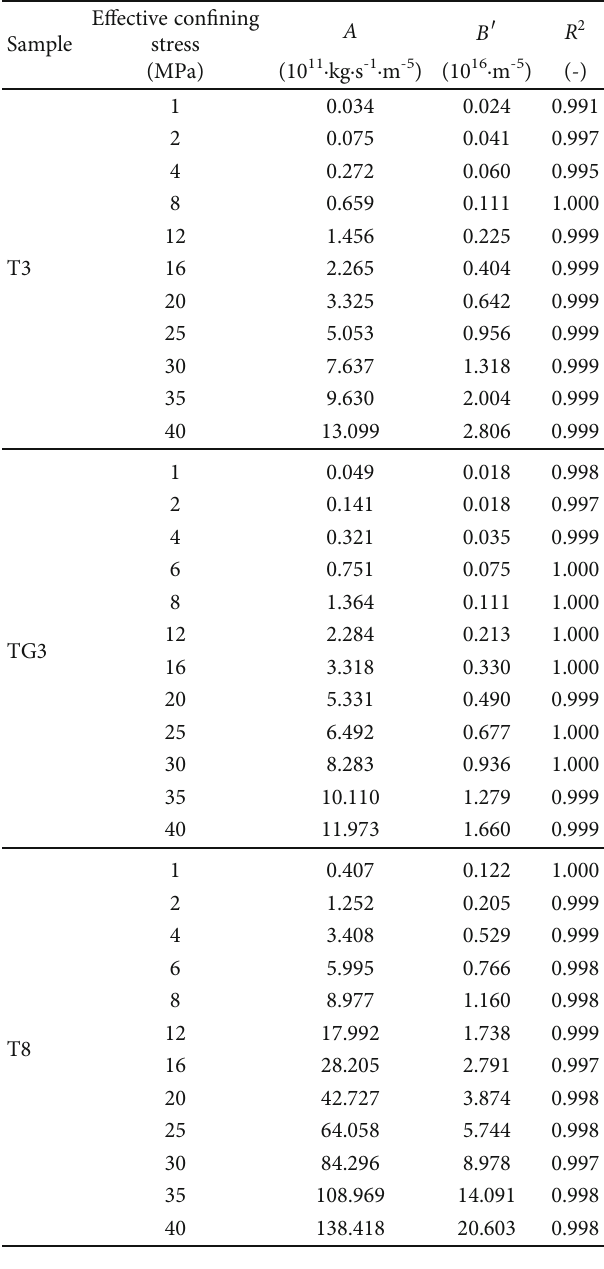
Table 3: Fitting parameters for equation